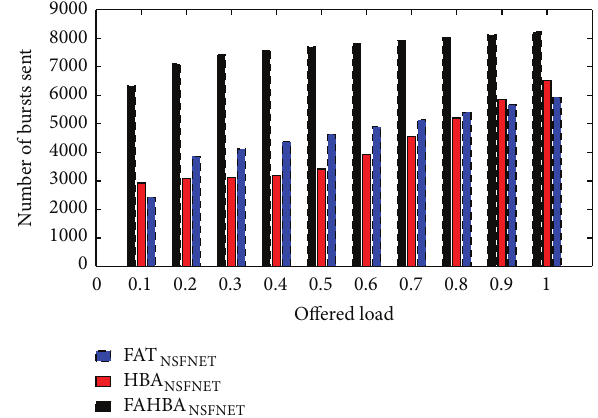
Figure 11: Number of bursts sent versus offered load.